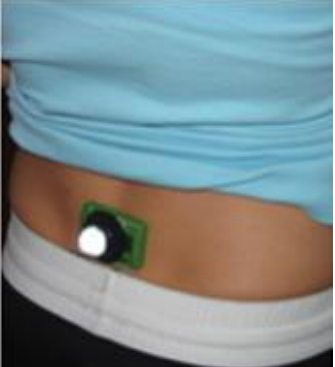
Figure 2. Typical sensor placement at S1 of the